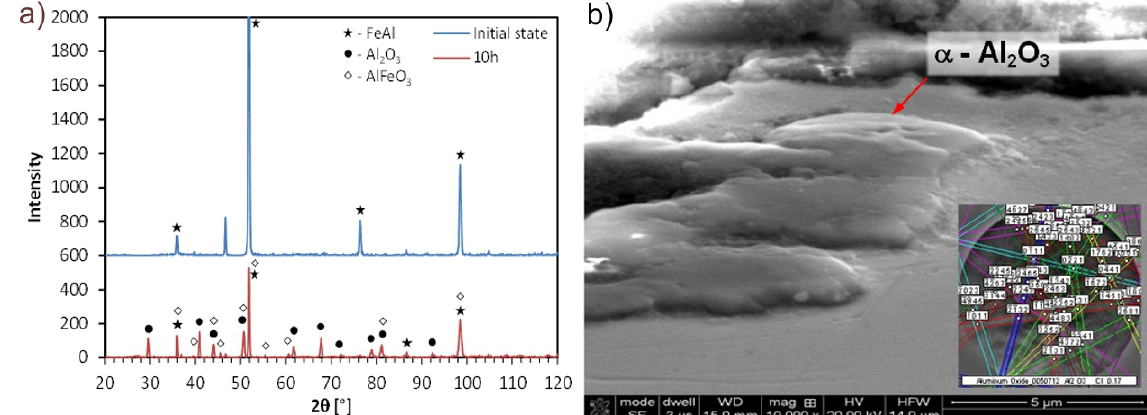
Figure 6. X-ray diffraction pattern of Fe-28Al-5Cr alloy in initial state and after oxidation at 1200 °C/10 h ( a ) and the structure of the oxide layer with an exemplary of Kikuchi pattern ( b